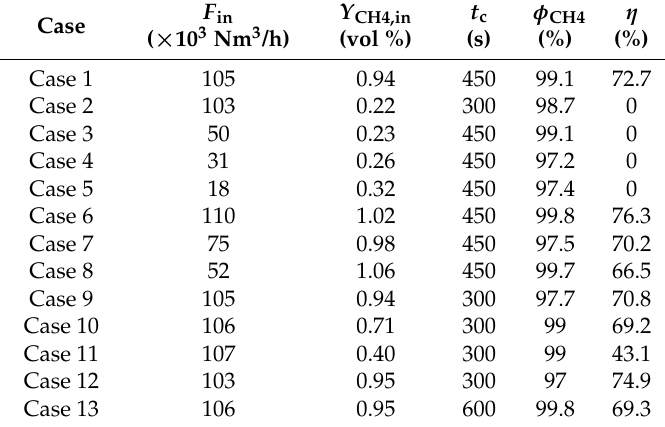
Table 2. Summary of the operating conditions and results for methane conversion ( φ CH4 ) and heat recovery efficiency ( η ) of the